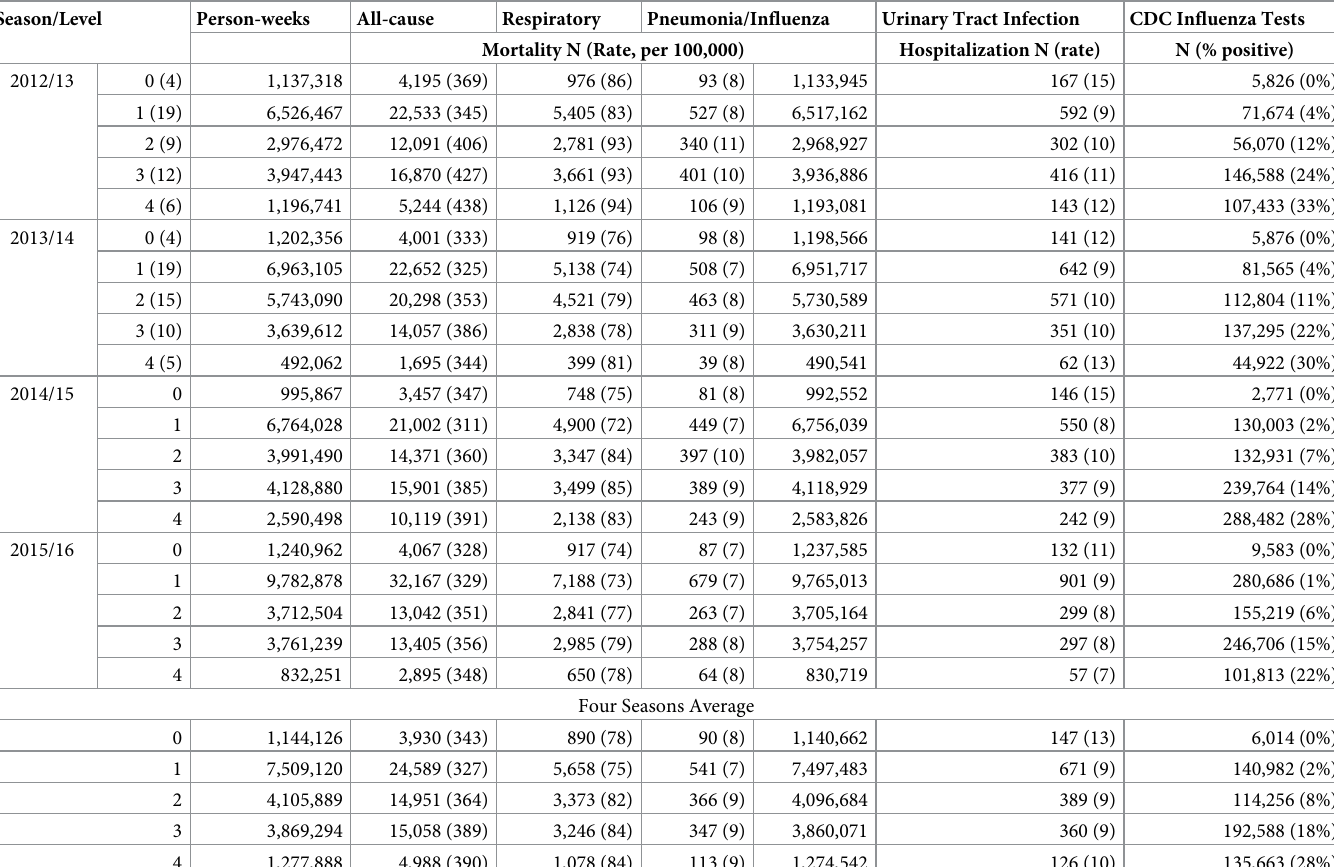
Table 1. Observed mortality rates by season and cause of